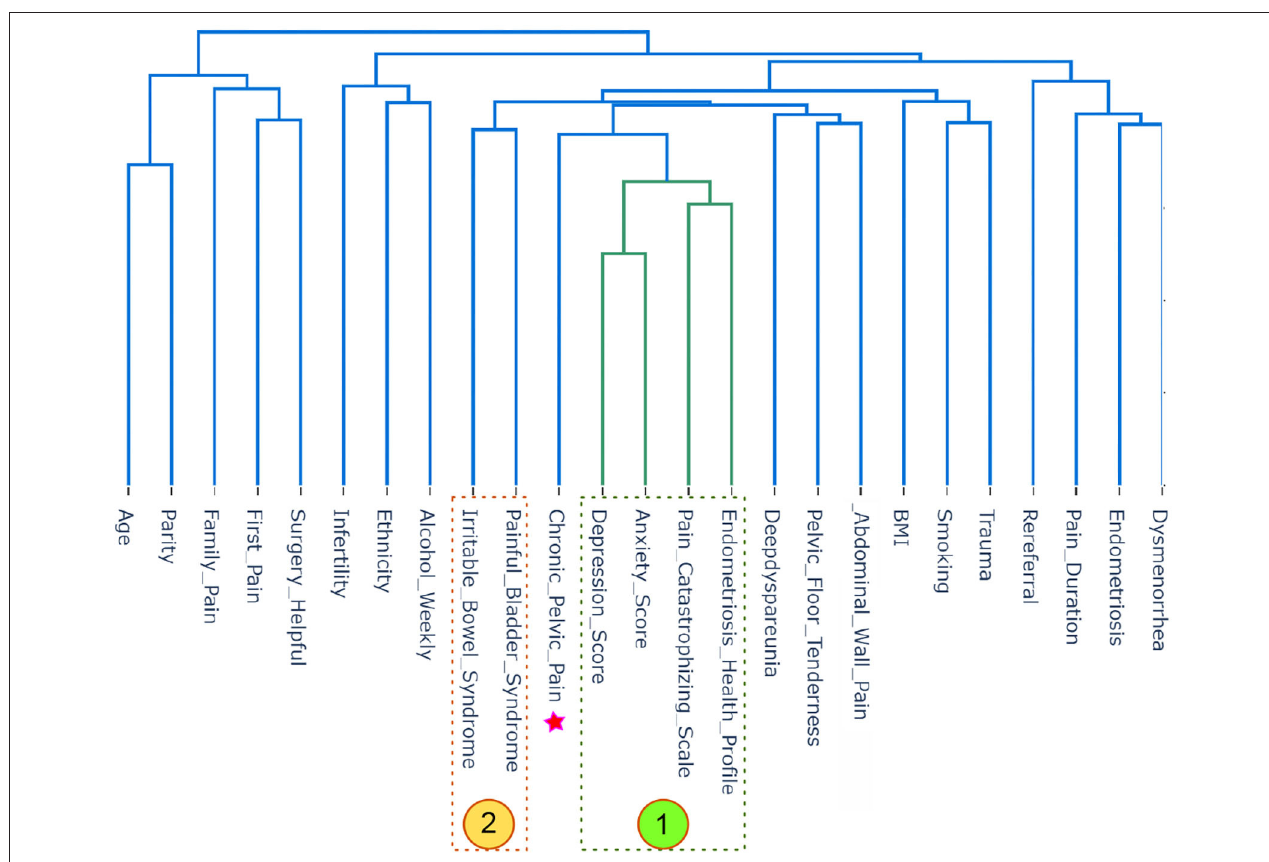
FIGURE 4 | Hierarchical cluster analysis (HCA) analysis of all 25 factors in the Pelvic Pain and Endometriosis database. The star represents the factor of interest, which is chronic pelvic pain (CPP). Four factors in zone #1 are directly associated with CPP, while two factors in zone #2 are indirectly associated with CPP.